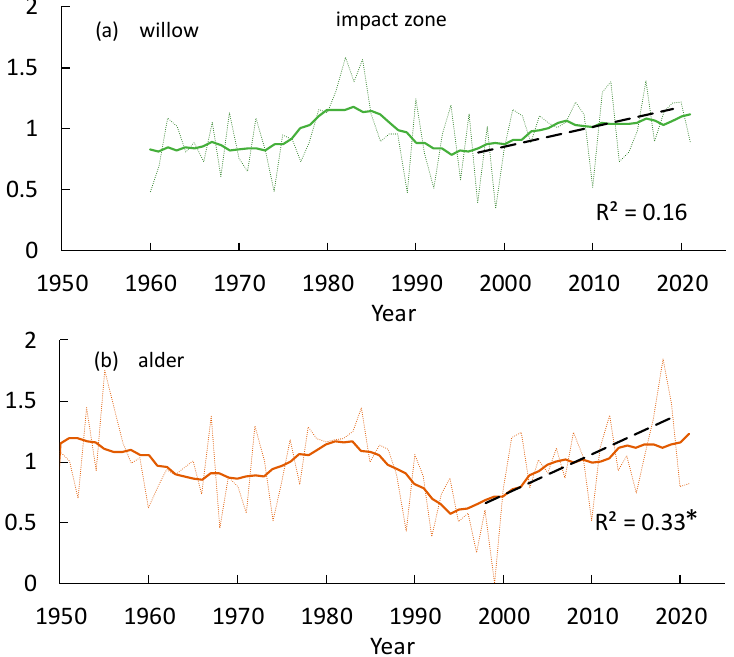
Figure 8. Comparative growth index dynamics of bushes (willow ( a ) and alder ( b )) in the impact zone. Solid lines indicate an 11-year moving average. Stars (*) indicate significant trends at p < 0.05.